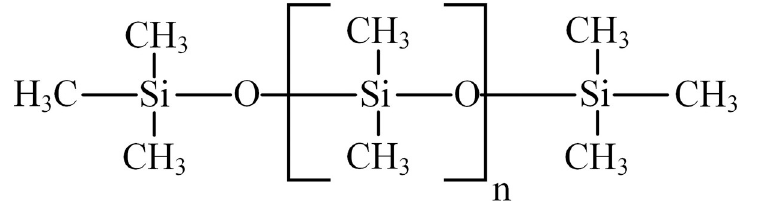
Fig 2. Molecular structure of polydimethylsiloxane